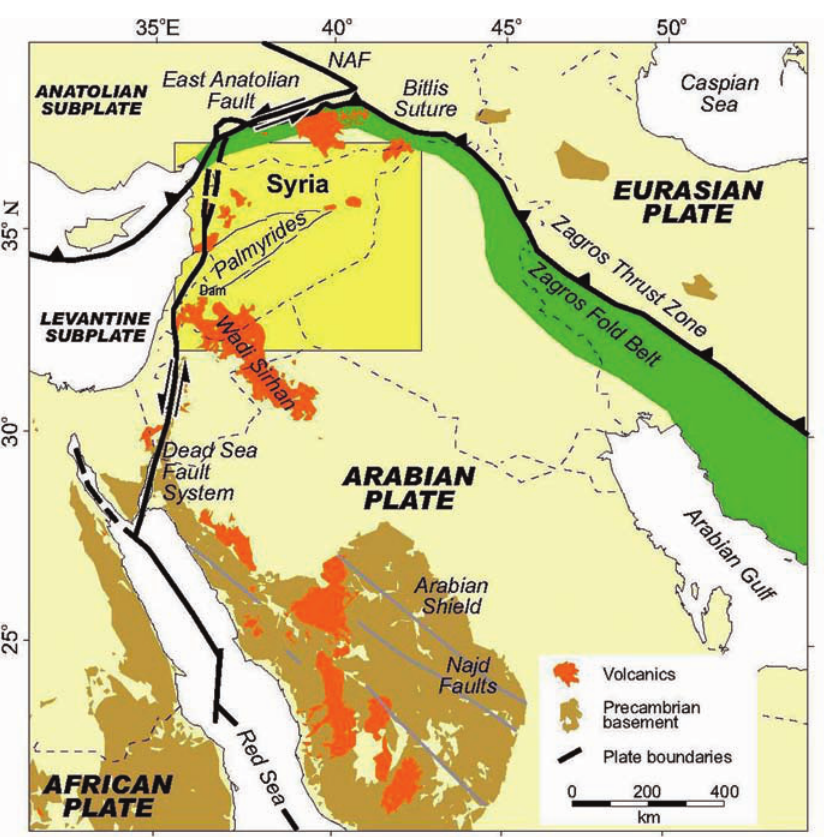
Figure 1. Regional tectonic map of the northern Arabian Plate and the surrounding regions, showing the proximity of Syria to many active plate boundaries. Dam, Damascus; NAF, North Anatolian Fault (modified from Brew et al. 2001). The yellow square shows the area in Figures 2, 3, 4 and 5.